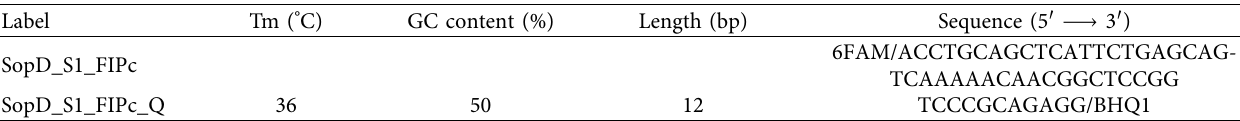
Table 2: SopD QUASR LAMP fuorophore-labeled primer and quencher probe set. Te 5 ′ end of the FIP primer was appended with the FAM reporter dye (a green fuorophore). A short quencher probe complementary to the 5 ′ end of the labeled primer (FIPc) was manually designed. Te quencher probe was modifed at the 3 ′ end with a dark quencher (e.g., Black Hole quencher